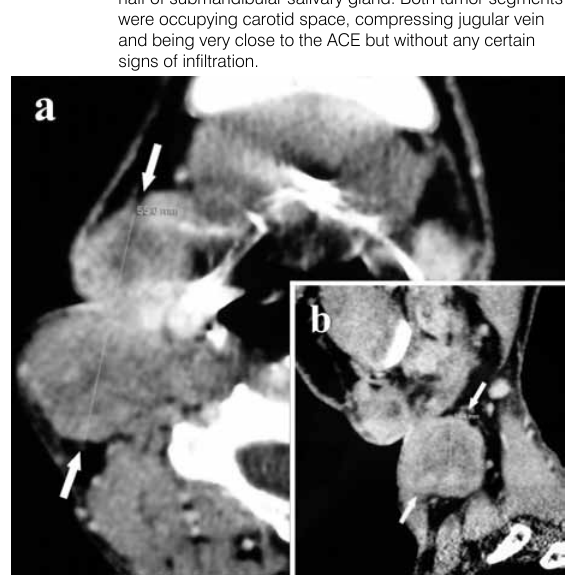
Figure 3. MDCT (a: cross section, b: sagittal section). Lobulated tumor mass (white arrows) was verified in the area of lower half of submandibular salivary gland. Both tumor segments were occupying carotid space, compressing jugular vein and being very close to the ACE but without any certain signs of infiltration.